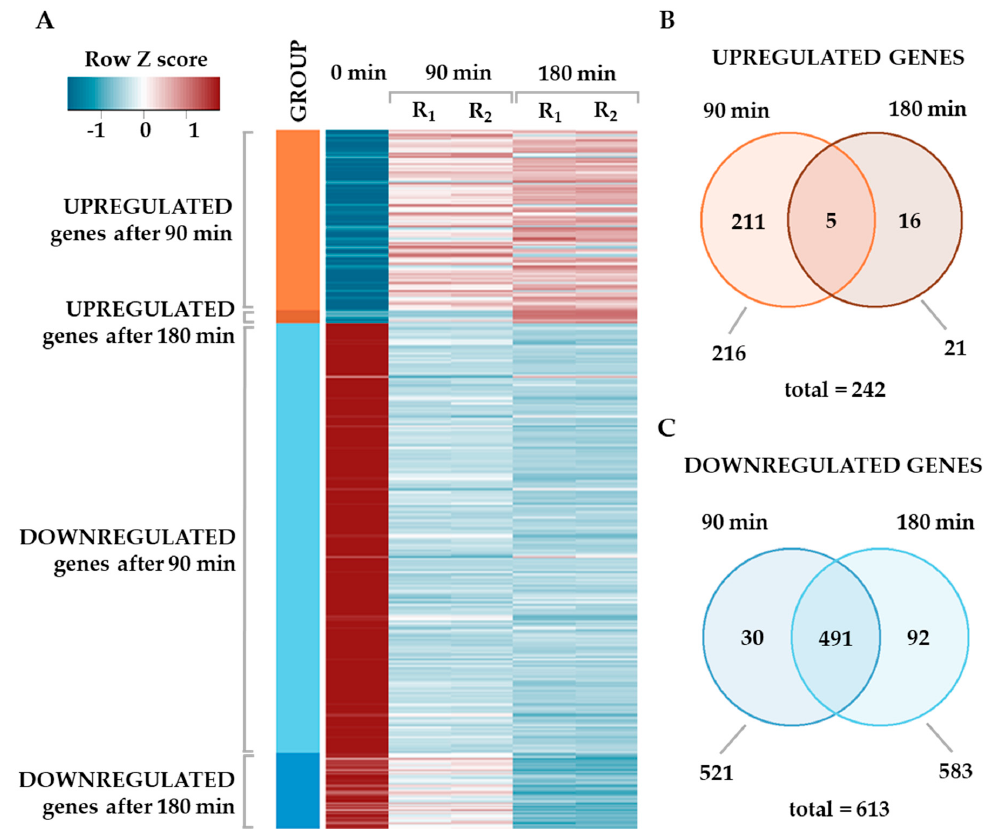
Figure 1. Changes in the global gene expression upon cold stress. ( A ) Heatmap presenting changes in gene expression for significantly altered genes (|log 2 FC| > 1 and adjusted p value <0.01). Column 0 stands for the control sample; replicates for 90 and 180 min time points are labeled R 1 and R 2 . Gene expression data are presented as Z-score transformed, scaled in rows values. ( B , C ) Venn diagrams representing overlap between differentially expressed genes at both time points.